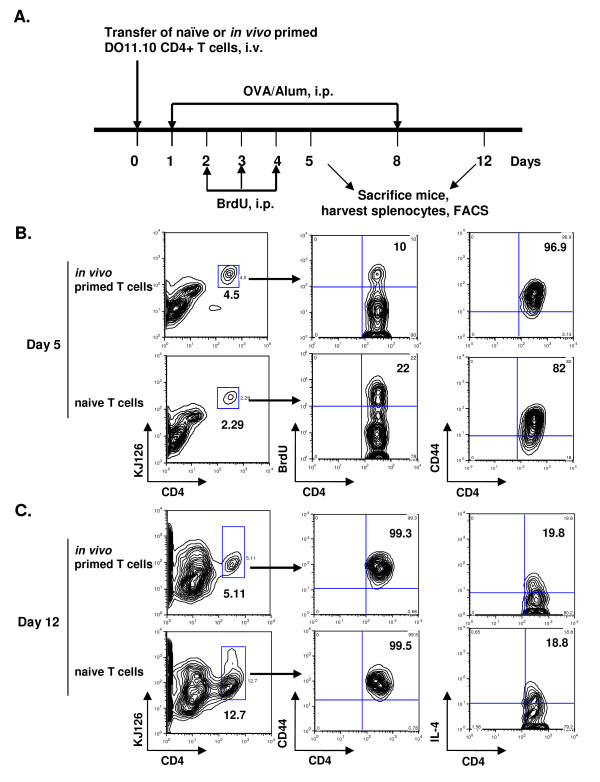
Comparison of proliferation and activation status of naïve vs. in vivo primed T cells. (A) Schematic representation of the protocol used in this experiment. Briefly, 1.5 × 106 naïve or in vivo primed CD4+ T cells were adoptively transferred into STAT6xRAG2-/- mice and primed with OVA/alum i.p. on day 1. One group of mice was treated daily with BrdU (1 mg/mouse) i.p for 3 days before harvesting spleens on day 5. Splenocytes were pooled together and total cell counts were recorded. Cells were stained with anitbodies to CD4, KJ126, CD44 and BrdU and flow cytometry was performed. Another group of mice, that didn't receive BrdU were immunized with OVA/alum a second time on day 8. Four days later, splenocytes were harvested, counted and stimulated with PMA (50 ng/ml) and Ionomycin (1 μg/ml) for 6 h. (B) BrdU and CD44 expression in the CD4+ KJ126+ population in the naïve T cell or in vivo primed T cell transfer groups are shown. (C) CD44 expression in the CD4+ KJ126+ population in naïve vs. in vivo primed T cell transfer groups on day 12 is shown. IL-4 production by naïve and in vivo primed DO11.10 CD4 T cells was measured by intracellular cytokine staining (ICS).